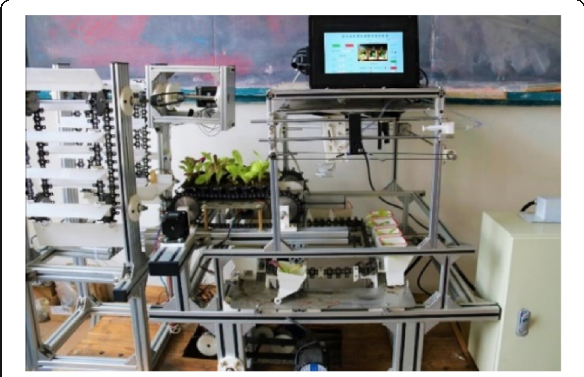
Fig. 9 Experiment of vegetable seedling